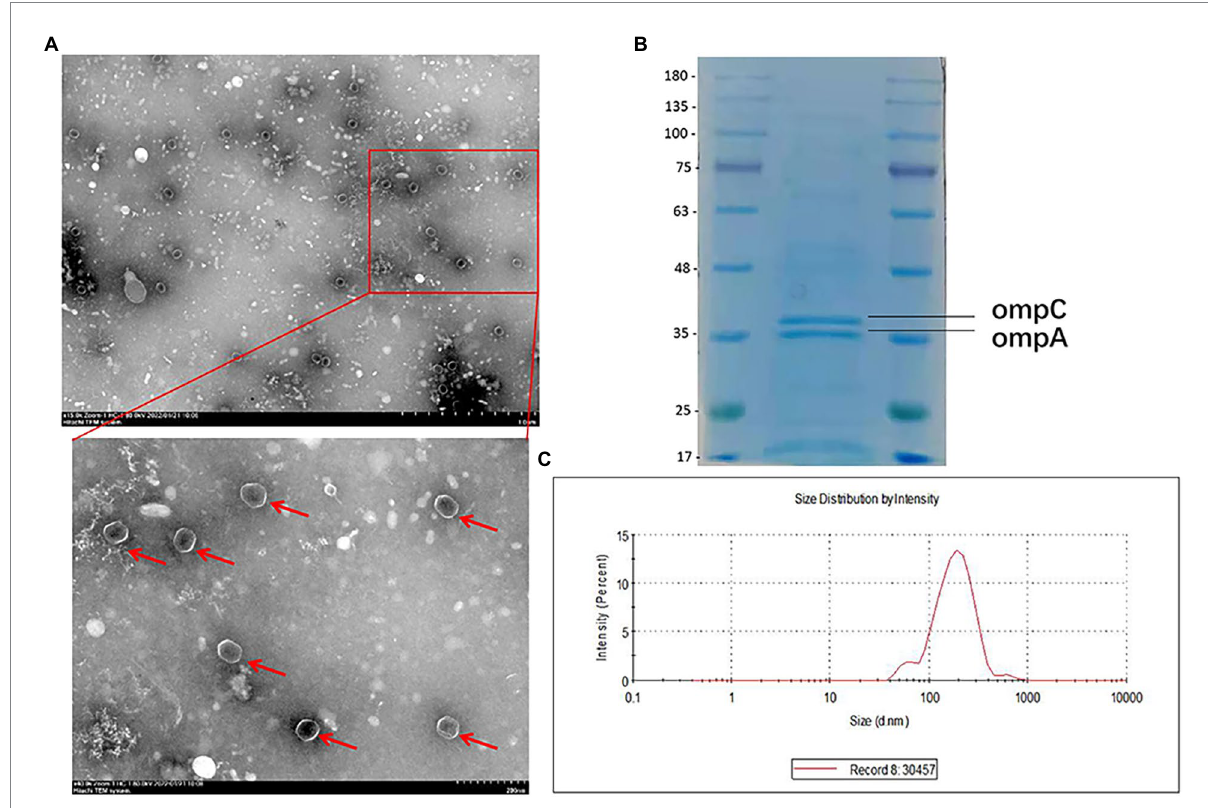
FIGURE 1 Characterization of OMVs derived from CR-HvKP. (A) Transmission electron microscopy (TEM) showed that CR-HvKP-derived vesicles had spherical bilayered structures. OMVS marked with red arrow. (B) Coomassie-stained SDS-PAGE (12%) protein profiles of CR-HvKP-derived vesicles. In the 35–48 kDa range, two major bands were detected in the OMVs. The molecular mass marker (MW) is expressed in kilodaltons (kDa). (C) DLS intensity-weighed distribution of OMVs derived from CRHvKP-derived